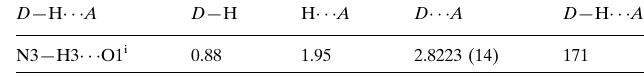
Hydrogen-bond geometry (A˚ , (cid:5)